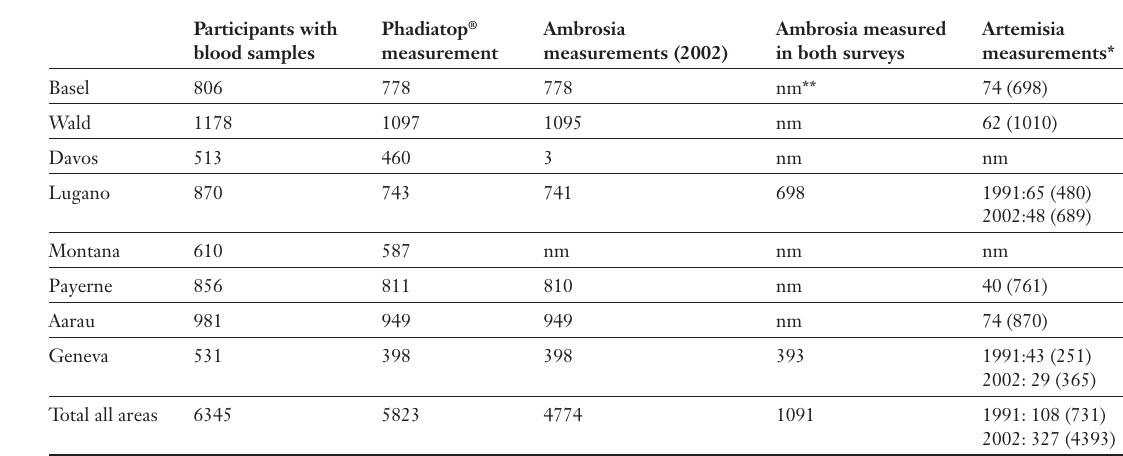
Number of samples tested by study area with valid results.